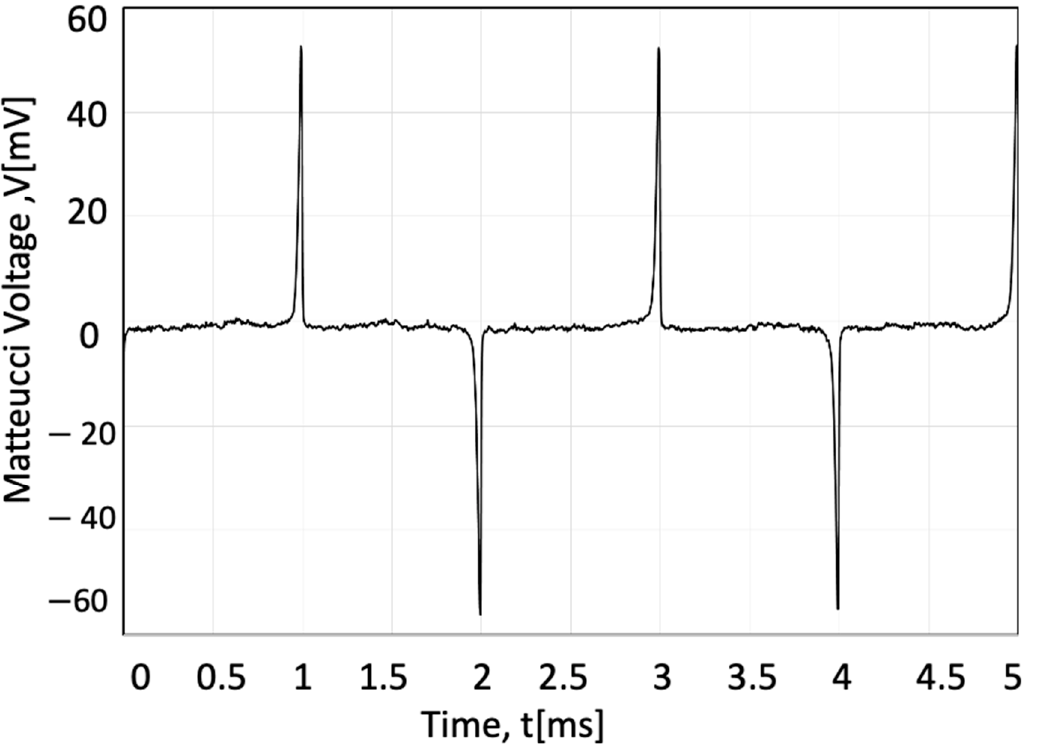
Figure 3. Output Matteucci voltage for the sensor magnetized with 0.9 kA/m magnetic field at 500 Hz frequency twisted 40°/cm (271 MPa torsion stress).